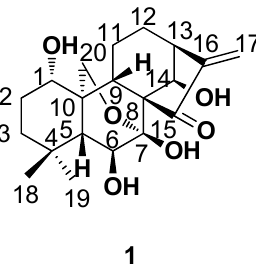
Figure 1. The structure and numbering of oridonin.